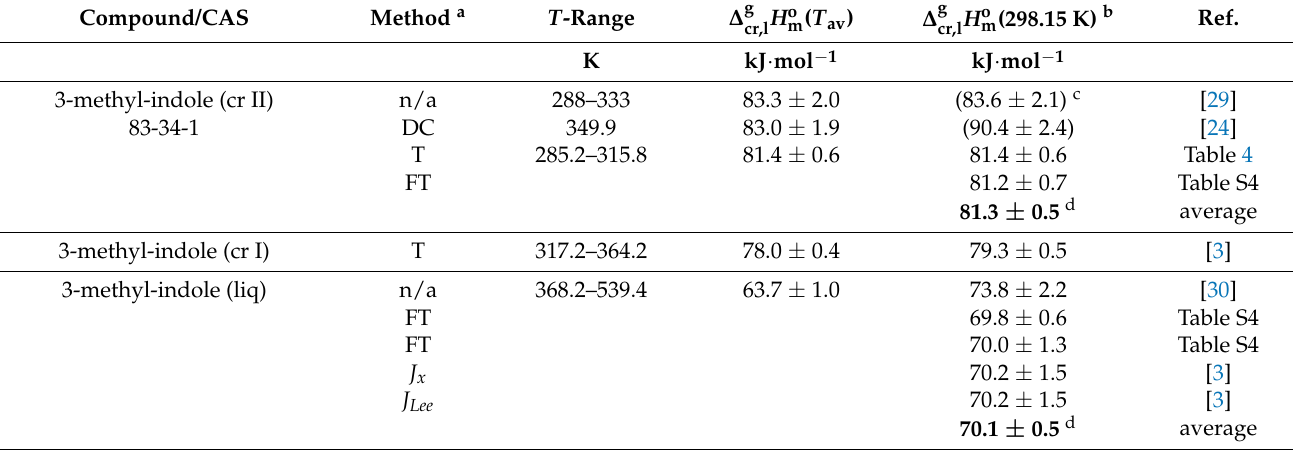
Table 5. Compilation of available enthalpies of sublimation/vaporization ∆ g substituted indole